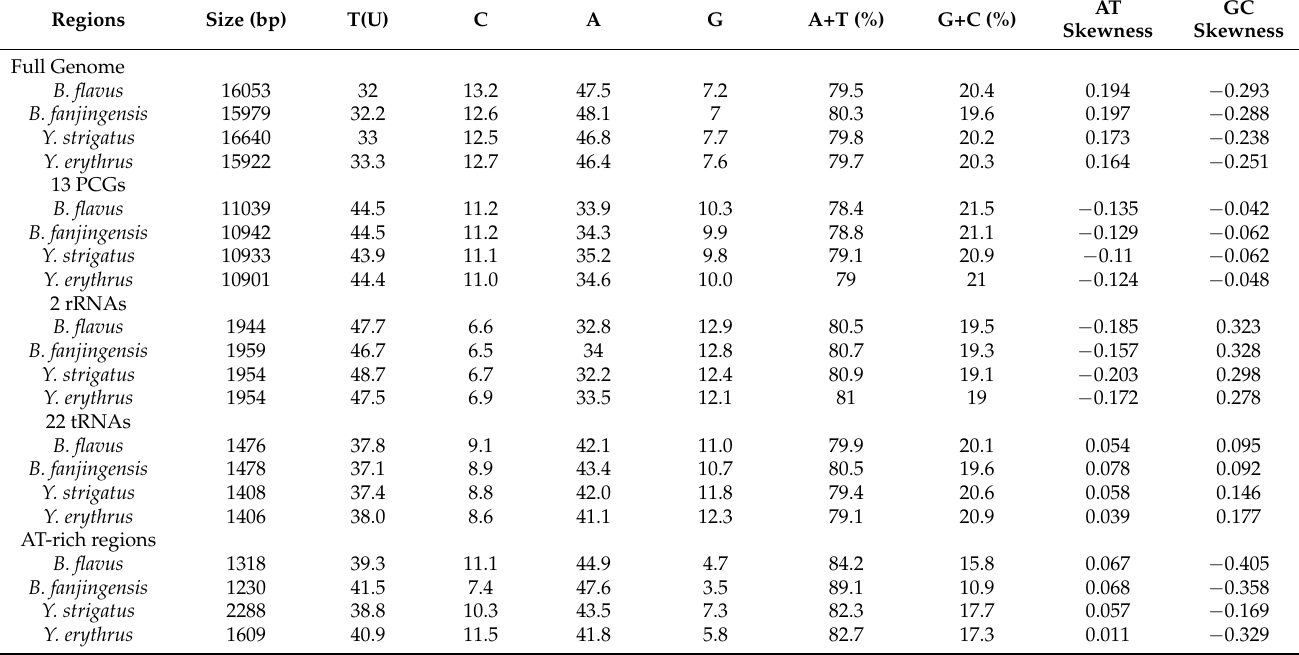
Table 2. Base composition of four mitochondrial whole genomes, 13 protein-coding genes (PCGs), 22 transfer RNAs (tRNAs), 2 ribosomal RNAs (rRNAs), and AT-rich regions.